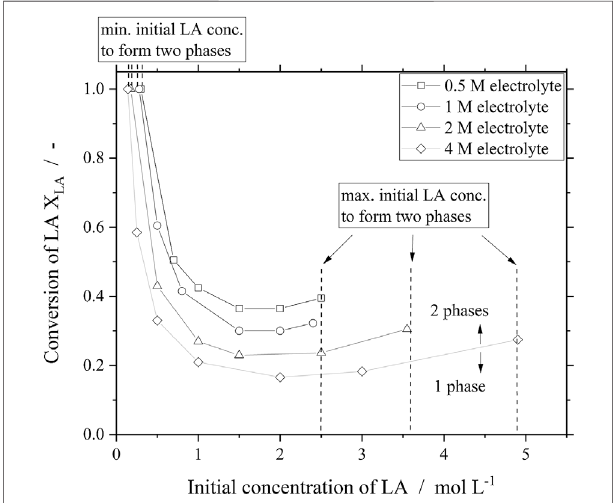
Frontiers in Energy Research |